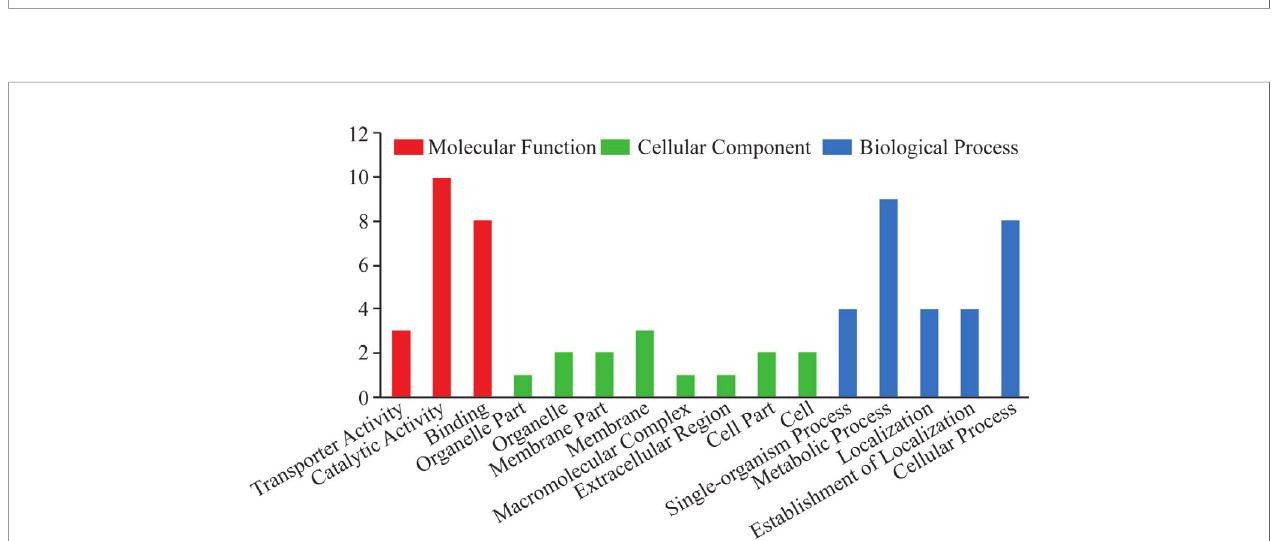
FIGURE 3 | GO enrichment analysis of all the identi fi ed T. gondii phosphoproteins. GO analysis of all the 38 identi fi ed phosphoproteins revealed that proteins in the “ biological process ” , “ cellular component ” , and “ molecular function ” categories were enriched. These phosphoproteins were suggested to be involved in the regulation of cellular processes including binding, location, and metabolism correlated with T. gondii invasion and